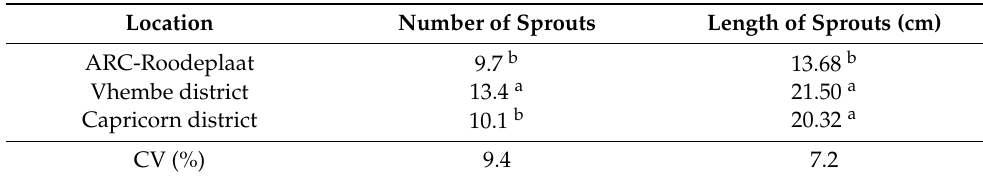
Table 2. ANOVA values and significant tests for the number of sprouts and length of Moringa oleifera from three agro-ecological zones. Mean Variance Degree of p Value Sum of Square Source of Variation Square Ratio Freedom Number of sprouts Treatments 2 41.0 20.5 18.7 ** Residual 12 13.1 Total 54.2 Treatments